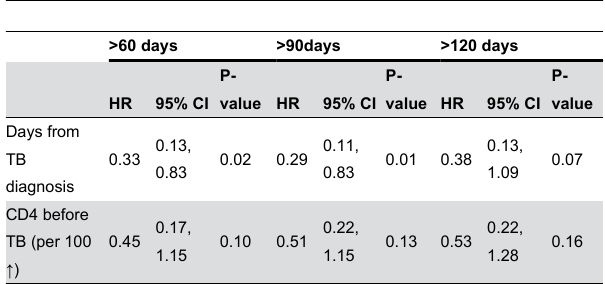
Table 5. Risk Factors for Death According to Time of ART Start after Tuberculosis